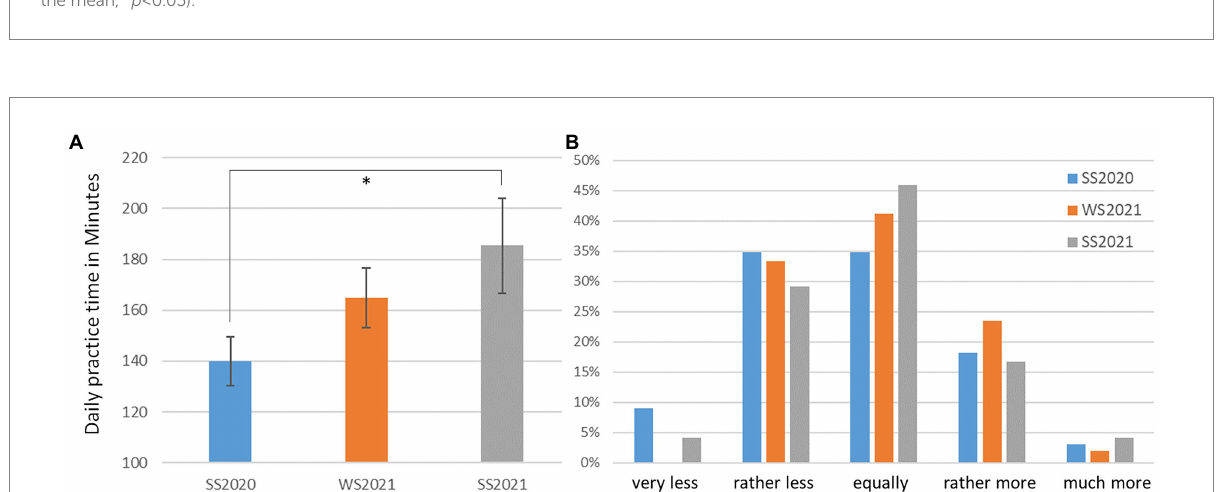
FIGURE 3 Ratings of the student’s experiences during each semester (the bold cross lines mark the mean value, the error bars present the standard error of the mean, * p <